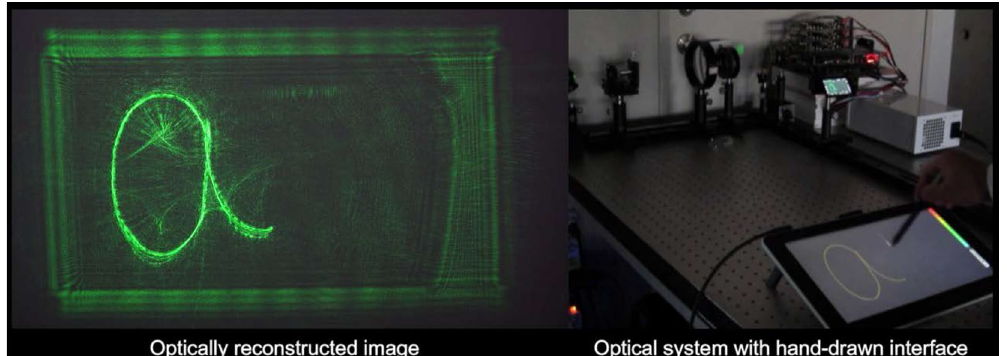
Figure 3. Example of drawing and projecting a 3D image.